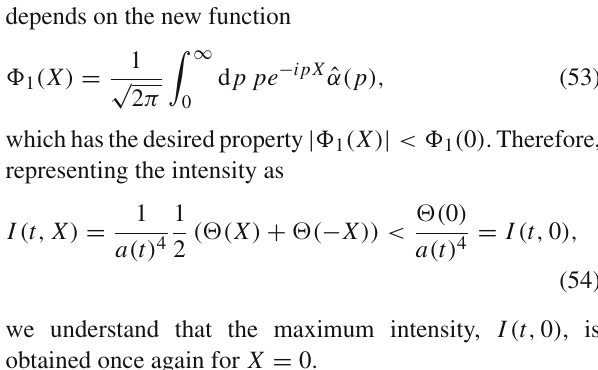
Fig. 1 The null geodesics of the maximum quantities of two fermions emitted simultaneously at the initial instant t = t 0 . The first one is emitted by the source S 1 inside the dynamical event horizon while the second one is emitted by the source S 2 outside it. The second fermion starts in the backward direction, stops at the time t stop when it restarts in the forward direction accelerating until arriving in O at the time t 2 > t 1